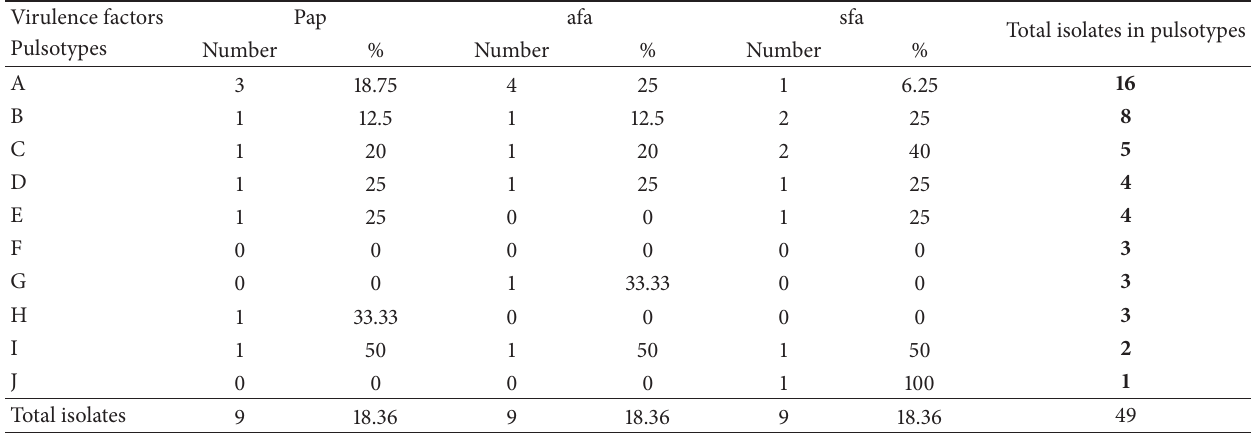
Table 3: Distribution of virulence genes in